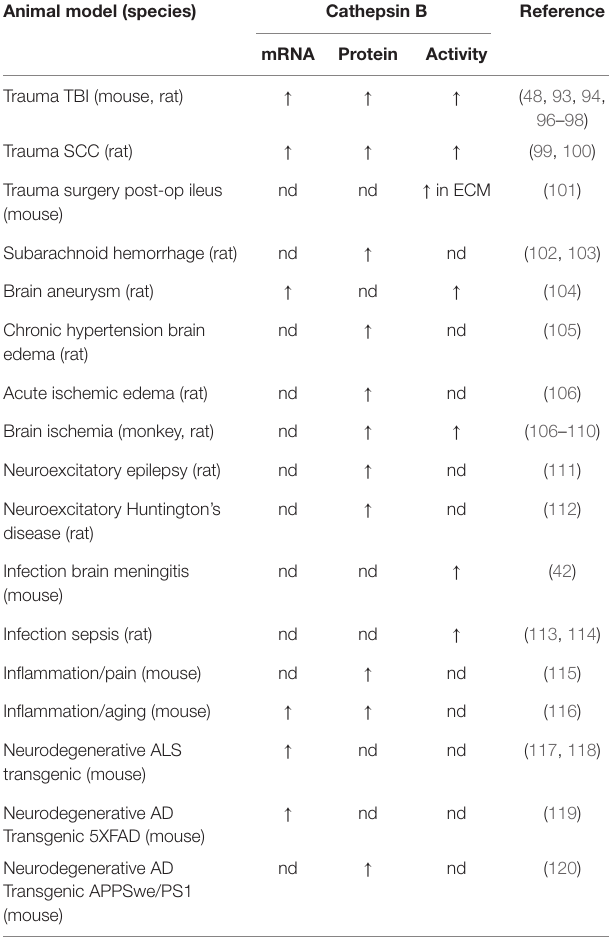
TABLe 1 | Cathepsin B is activated in TBi and TBi-related animal